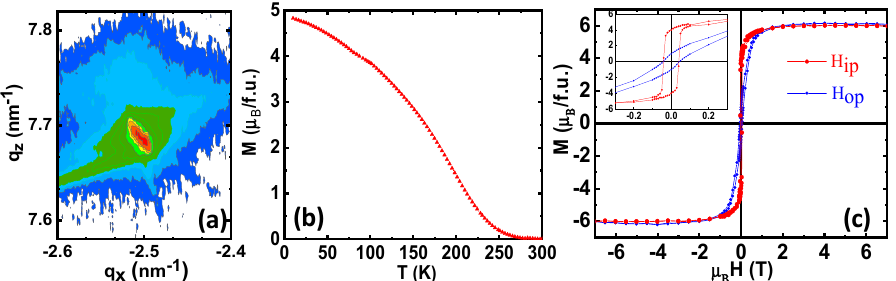
Figure A1. ( a ) RSM around (103) reflection of LNMO900 ◦ C thin film (thickness, t = 42 nm) with in-situ annealing temperature at 900 ◦ C ( b ) In-plane magnetization as a function of temperature under an applied field of µ 0 H = 0.5 T. ( c ) In-plane and out-of-plane hysteresis loops M(H) at 10. Inset shows the low field region in detail.